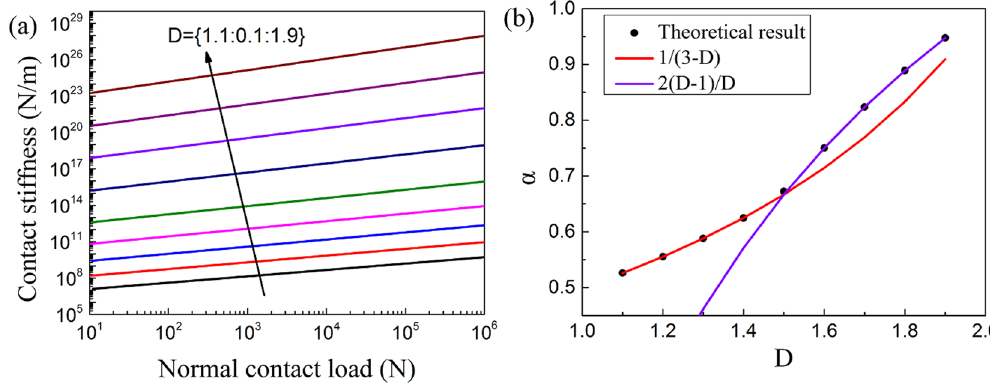
Figure 4. ( a ) Theoretical variations of the contact stiffness versus the normal load for different fractal dimensions when G = 1 × 10 − 22 . ( b ) Dependency of the power α in the force-stiffness-relation versus D . The minimum coefficient of determination R 2 of the curve fitting within the 1.1 ≤ D ≤ 1.9 range is larger than